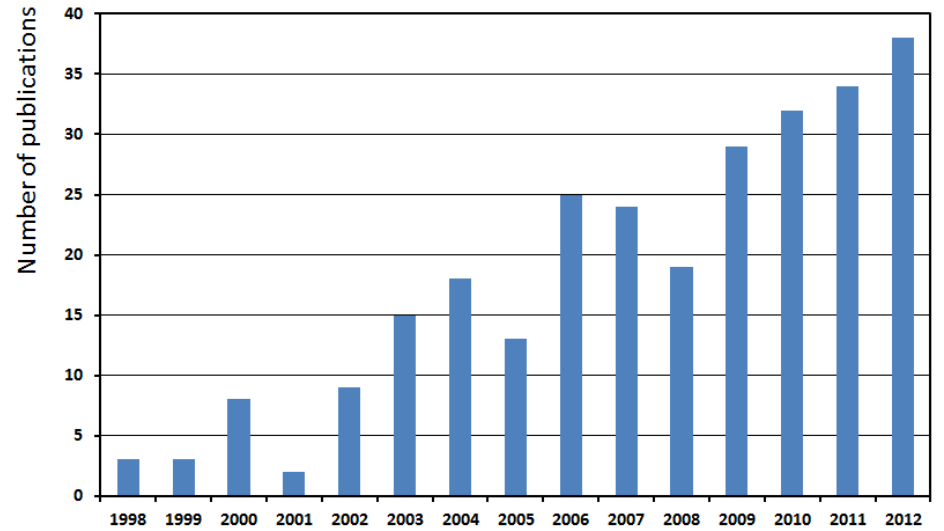
Figure 1. Number of papers published on non-Eu 2+ -doped persistent luminescent compounds, according to the Web of